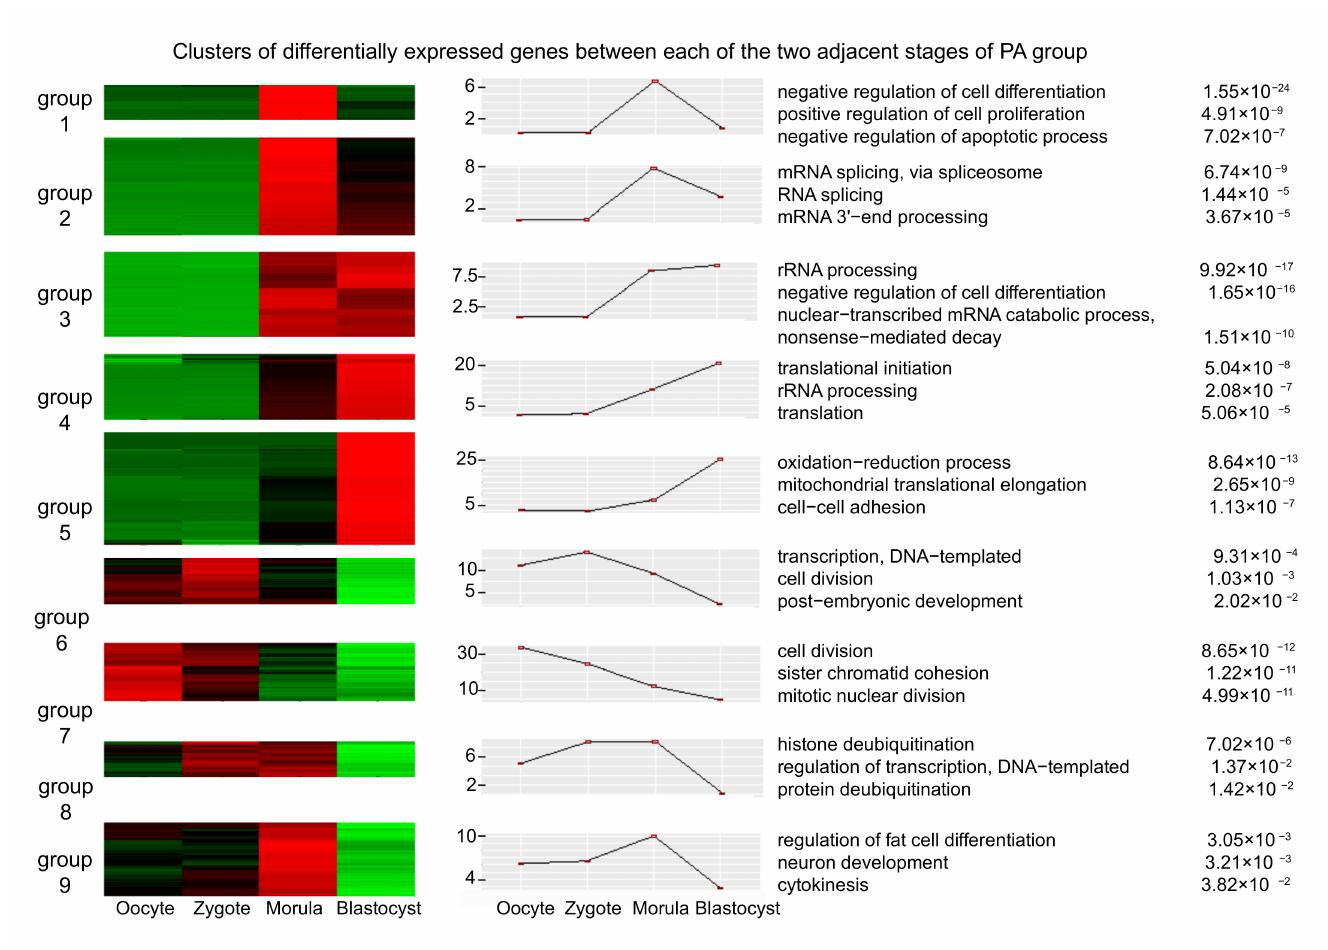
Figure 2. Clusters of DEGs between two adjacent stages of pig parthenogenesis activation (PA) embryos. Gene average log transformed expression values, top GO terms, and corresponding enrichment p -values were